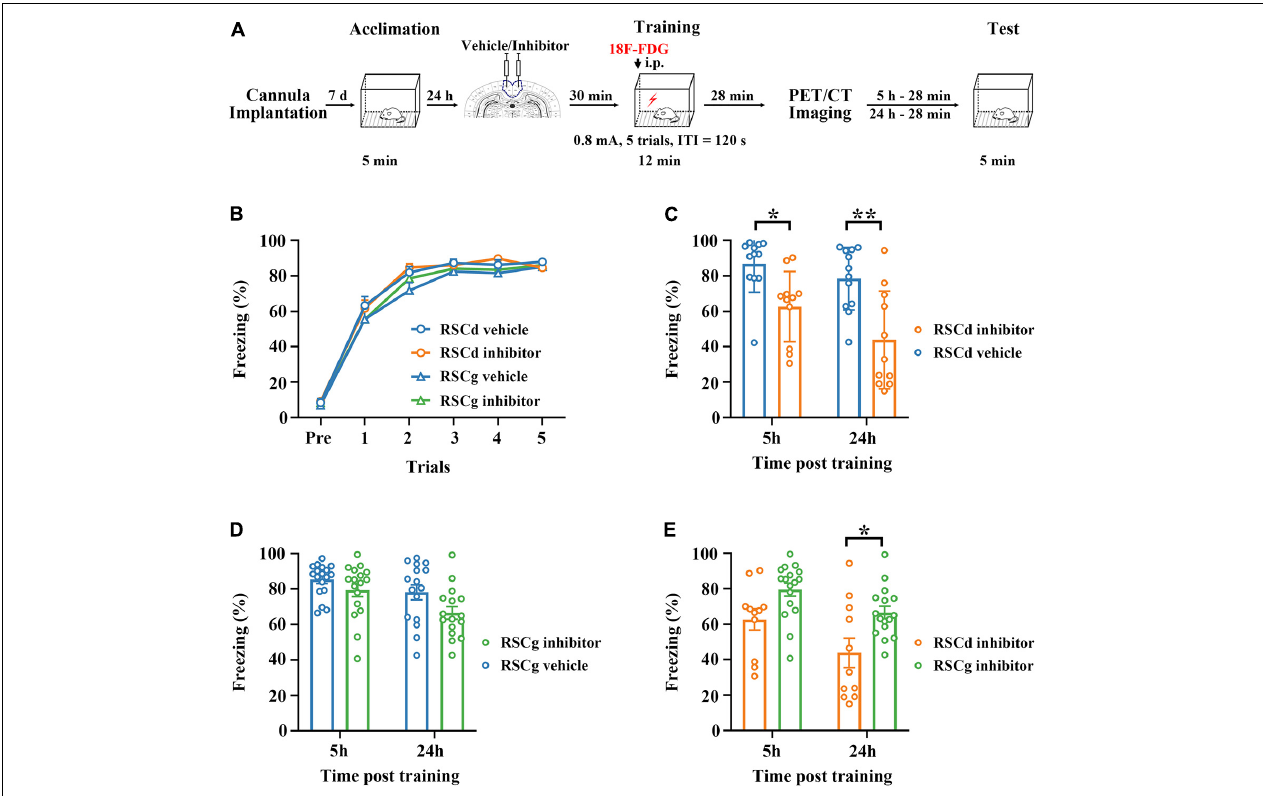
FIGURE 1 | Effects of suppressed RSCd/g on contextual fear memory formation. (A) Diagram for experimental procedures. (B) The learning curves of four group rats (RSCd vehicle/inhibitor group and RSCg vehicle/inhibitor group) show no significant difference; RSCd vehicle group n = 24, inhibitor group n = 22; RSCg vehicle group n = 35, inhibitor group n = 32. (C) Memory retrieval during the 5-h and 24-h post-learning tests are significantly impaired in the RSCd inhibitor independent groups compared to the RSCd vehicle independent groups; 5 h, RSCd vehicle group n = 12, inhibitor group n = 11; 24 h, RSCd vehicle group n = 12, inhibitor group n = 11. (D) There is no significant difference in memory retrieval between the RSCg inhibitor independent groups during the 5-h and 24-h post-learning tests compared to the RSCg vehicle independent groups; 5 h, RSCg vehicle group n = 18, inhibitor group n = 16; 24 h, RSCg vehicle group n = 17, inhibitor group n = 16. (E) Memory retrieval during the 5-h and 24-h post-learning is significantly impaired in the RSCd inhibitor groups compared to the RSCg inhibitor groups; 5 h, RSCd inhibitor group n = 11, RSCg inhibitor group n = 16; 24 h, RSCd inhibitor group n = 11, RSCg inhibitor group n = 16. ITI, intertrial interval; i.p., intraperitoneal injection. * p < 0.05, ** p < 0.01, two-way ANOVA followed by Bonferroni’s posttests.